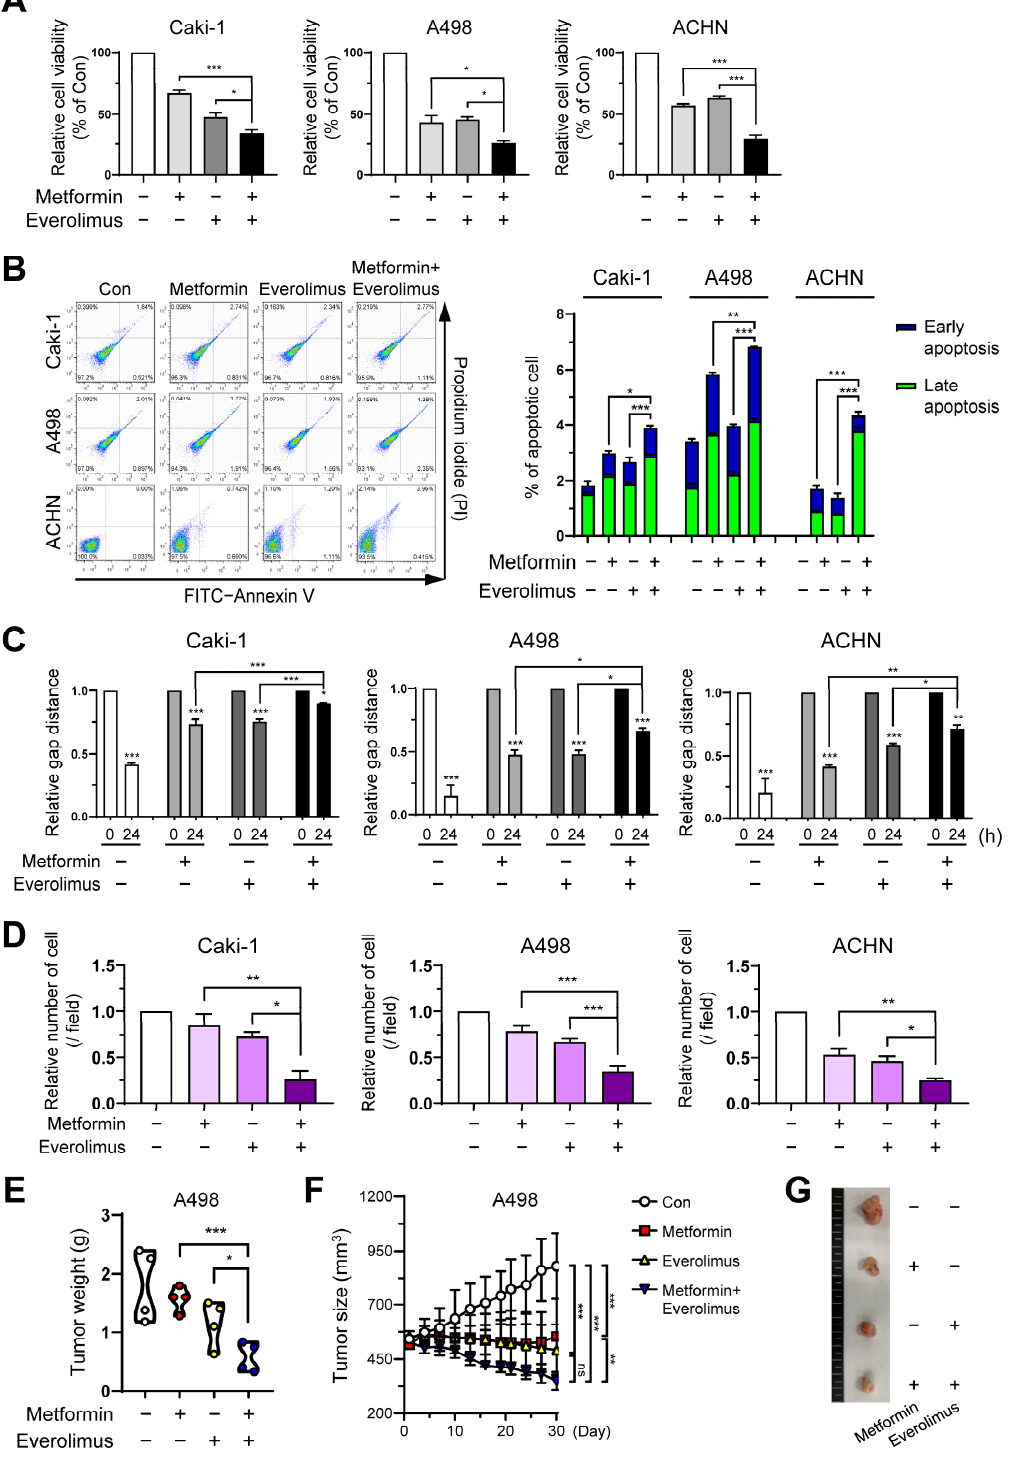
Figure 1. Combination treatment of metformin and everolimus synergistically inhibits RCC: ( A ) Caki-1, A498, and ACHN cells were treated with the control (absence) and metformin (20 mM), and